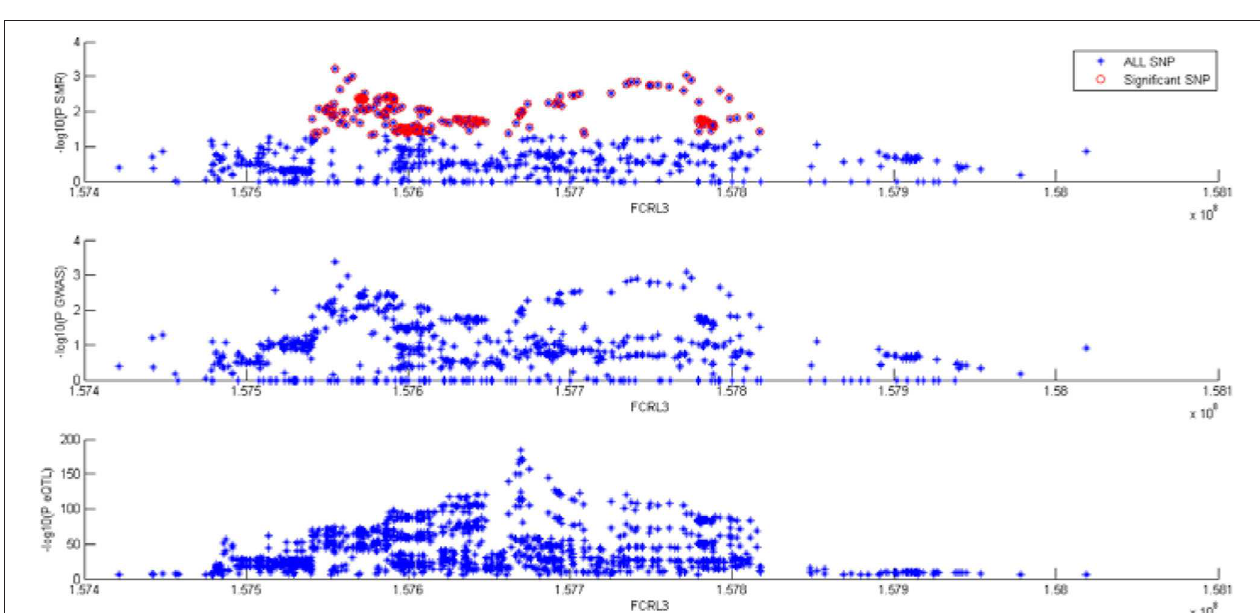
FIGURE 8 | SMR tests for association between gene FCRL3 expression and complex traits.